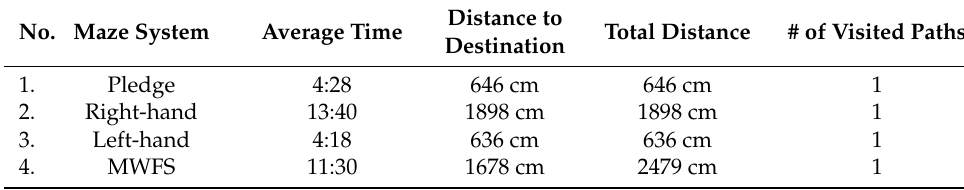
Table 6. Experimental results obtained from the first experiment